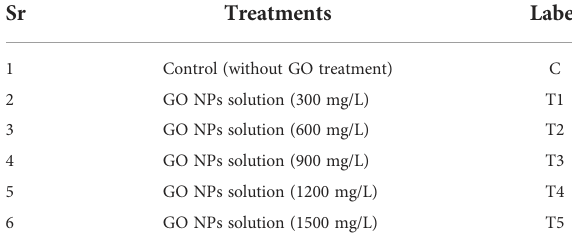
TABLE 1 Treatments for evaluating the ef fi cacy of green synthesized GO NPs to augment mungbean plant growth and yield in vivo . Sr